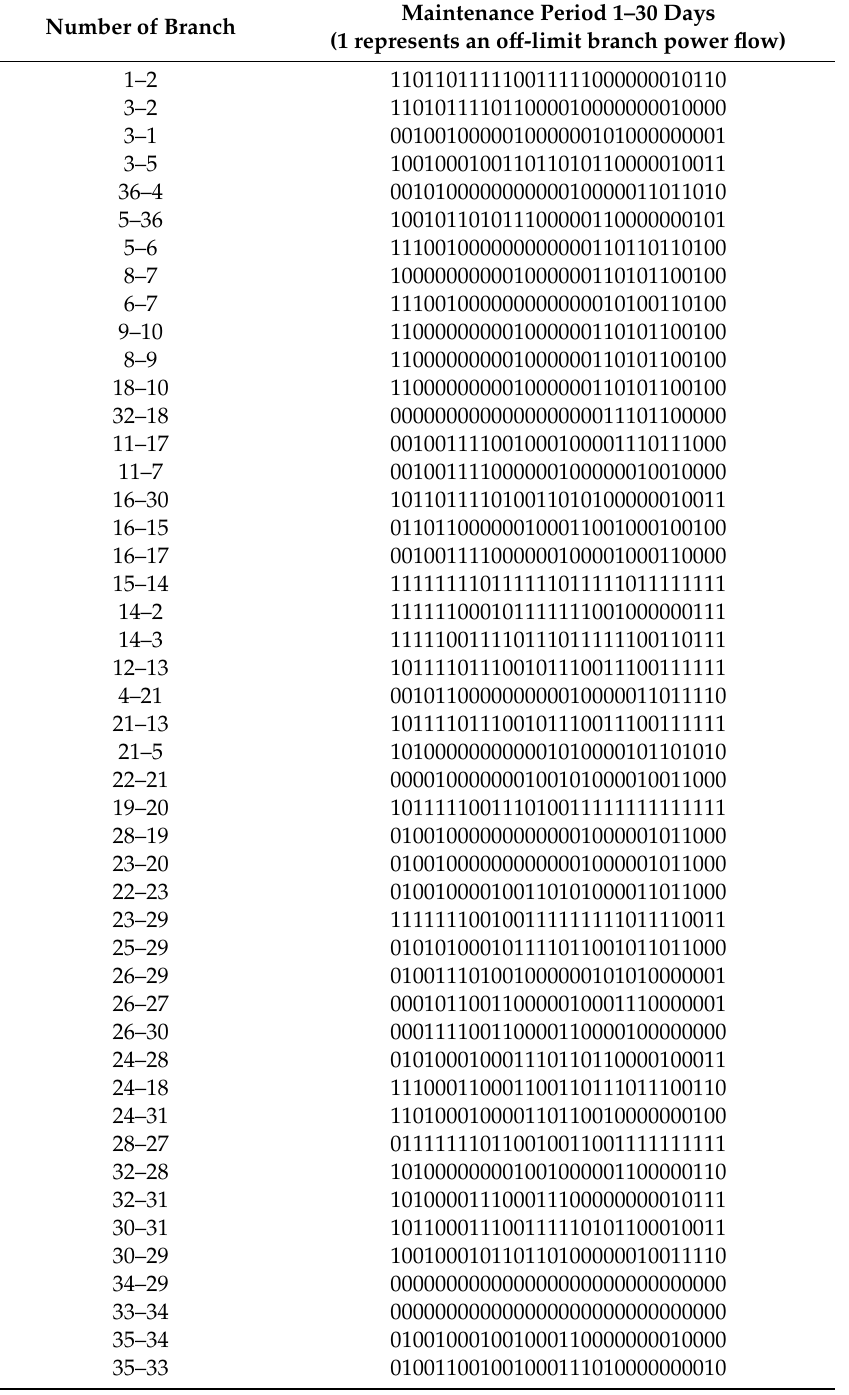
Table A8. Solution C o ff -limit branch power flow in the Hubei electrical